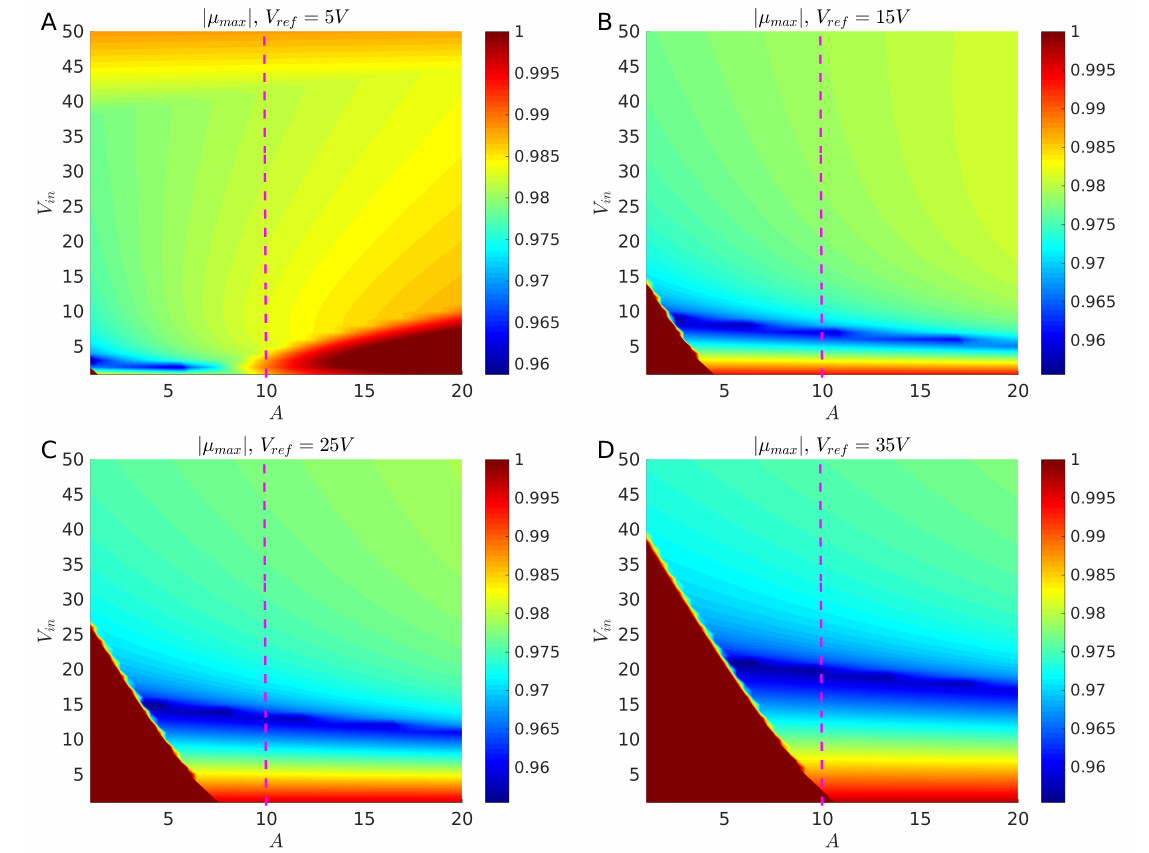
Figure 3. Norm of the maximal Floquet multiplier as a function of the input voltage V in and the ramp slope A at a fixed value of V ref , indicated on the title of each panel. ( A ) V ref = 5 V; ( B ) V ref = 15 V; ( C ) V ref = 25 V; ( D ) V ref = 35 V. In all panels, the magenta dashed line denotes the selected value of A = 10 that guarantees stable operation for most of the parameters